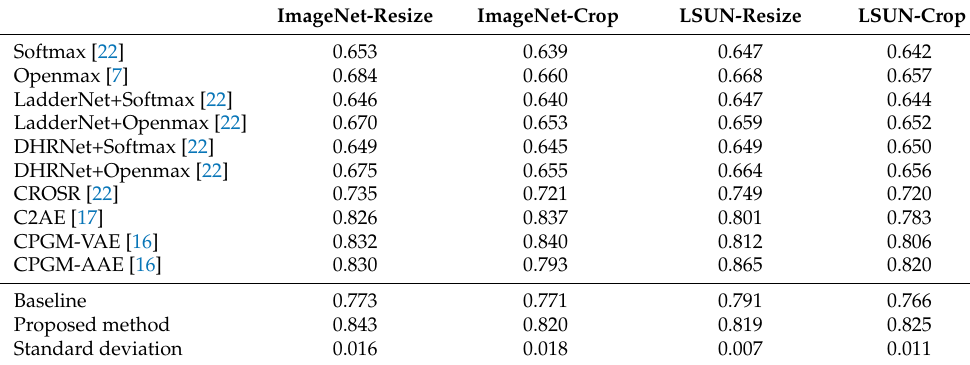
Table 1. F1 scores on 11 classes (10 known and unknown) tested on various